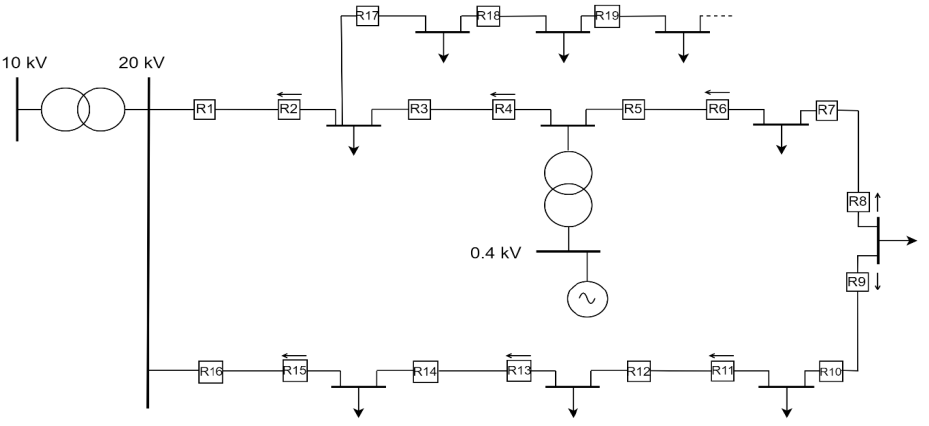
Figure 15. An example of a closed loop MV meshed distribution network with a connected DG unit.